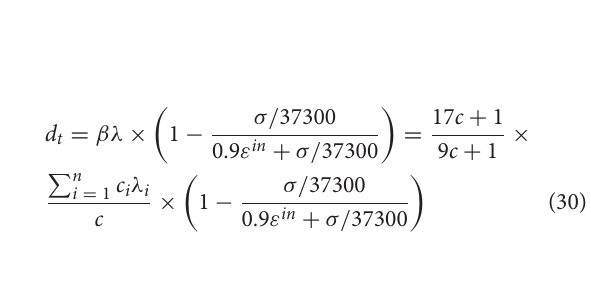
FIGURE 7 | The scatter plot about the coefficient β and the